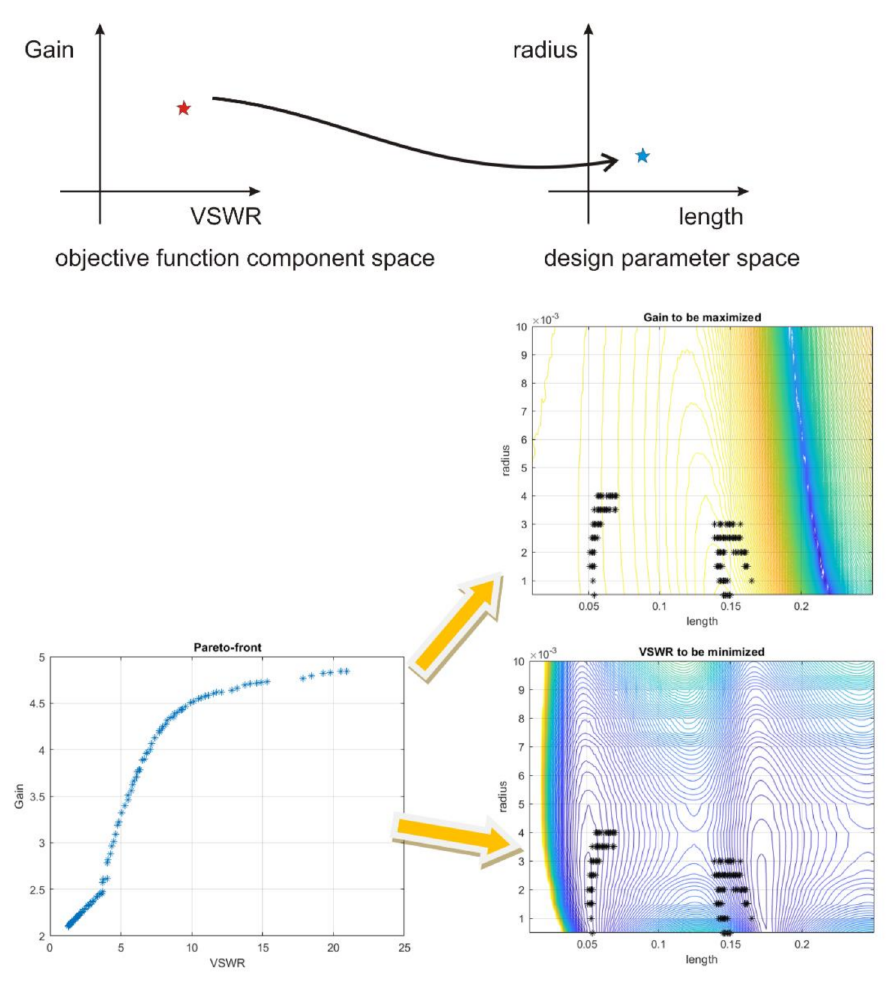
Figure 7. Results of P–EStra optimization located on Pareto–front in objective space and in design